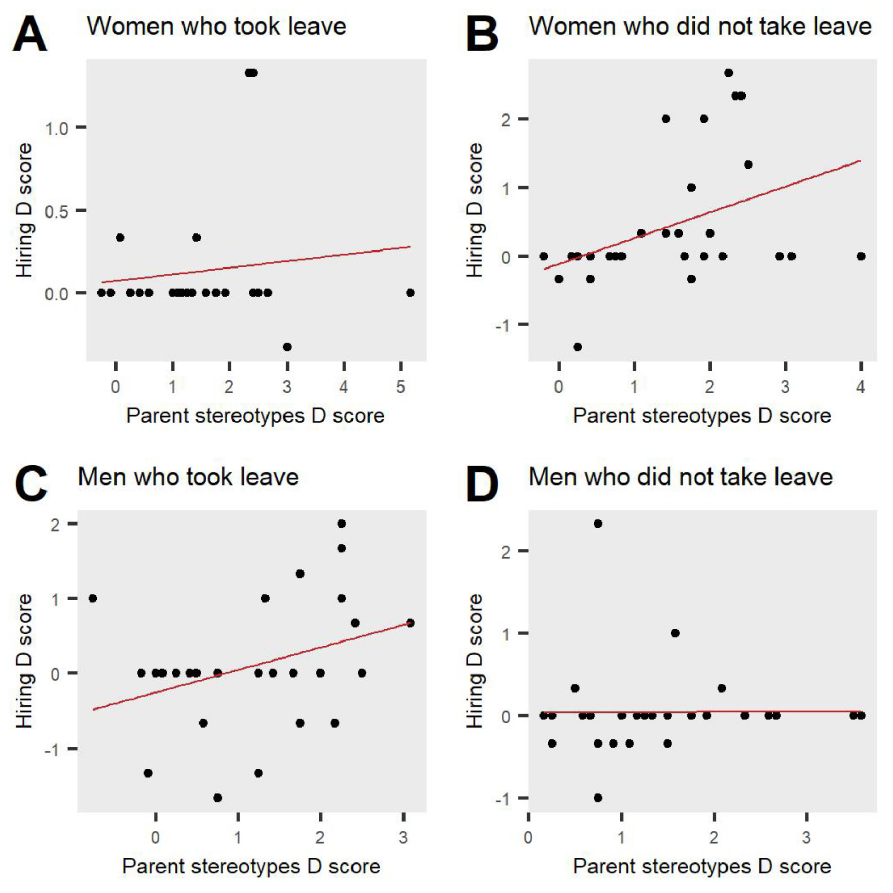
Fig 6. Parent-academia stereotypes significantly predict biased decisions in hiring. More stereotypes lead to a reduced likelihood to endorse hiring parents compared to non-parents, specifically men who took leave and women who did not take